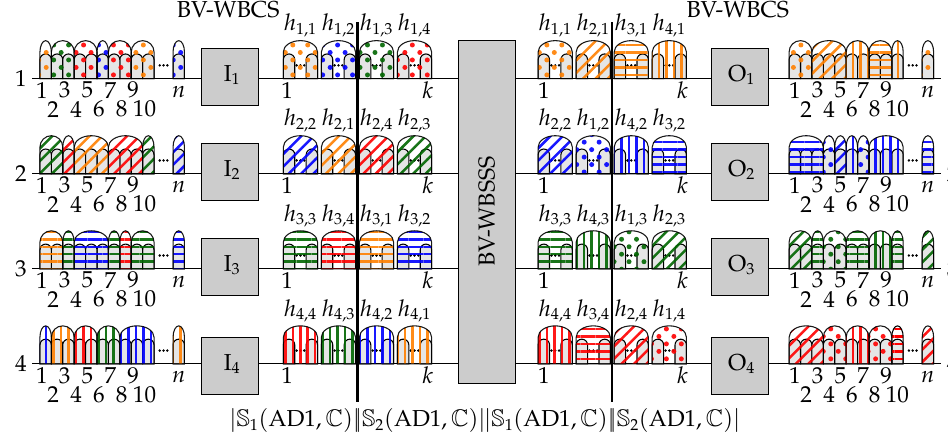
Figure 1. A general architecture of WSW1 ( r , n , k ) and connections